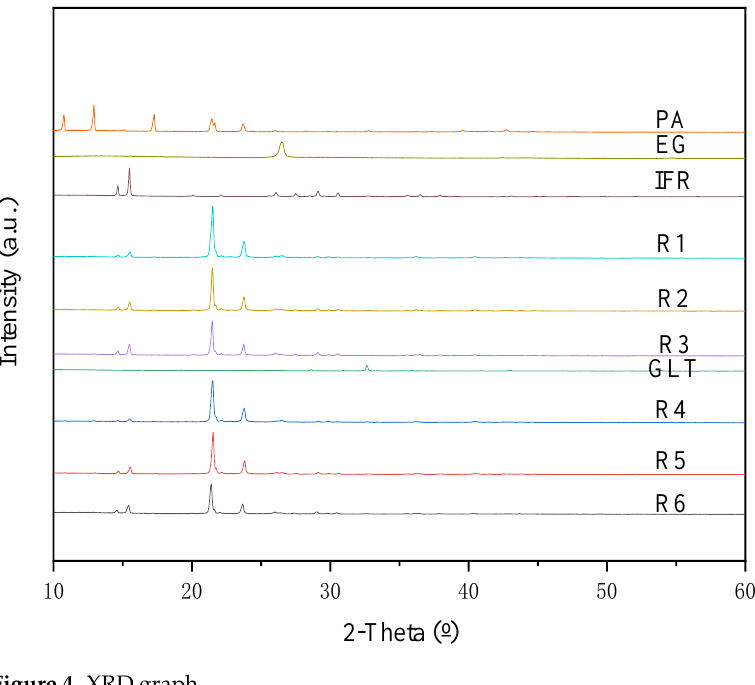
Figure 4. XRD graph.